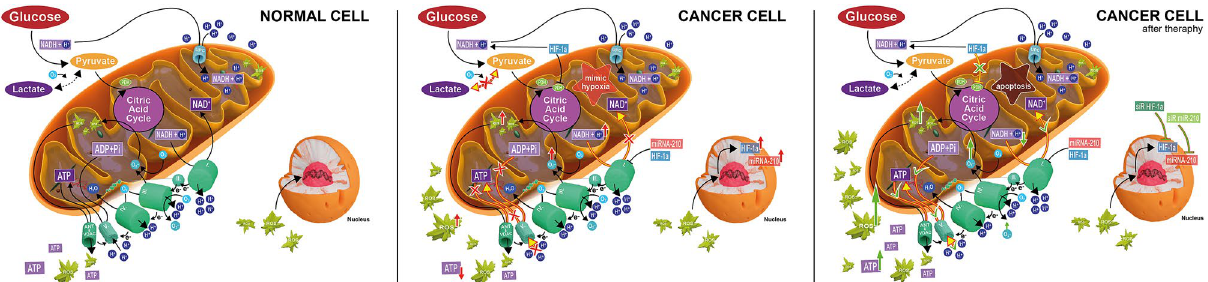
Figure 1. Mitochondria; normal cell: ROS is produced naturally, this ROS are deactivated by the anti-oxidation activity of enzymes as SOD which expression is stimulated; cancer cell: due mimic hypoxia cells uncouple the OXPHOS, accumulate NADH, increase ROS and activate expression of hypoxic survival genes as HIF-1α and miR-210; cancer cell after gene-therapy: due to gene silencing of HIF-1α and miR-210, the cancer cells lead to apoptosis because of re-activating of OXPHOS, increase in ROS and secreting of apoptic